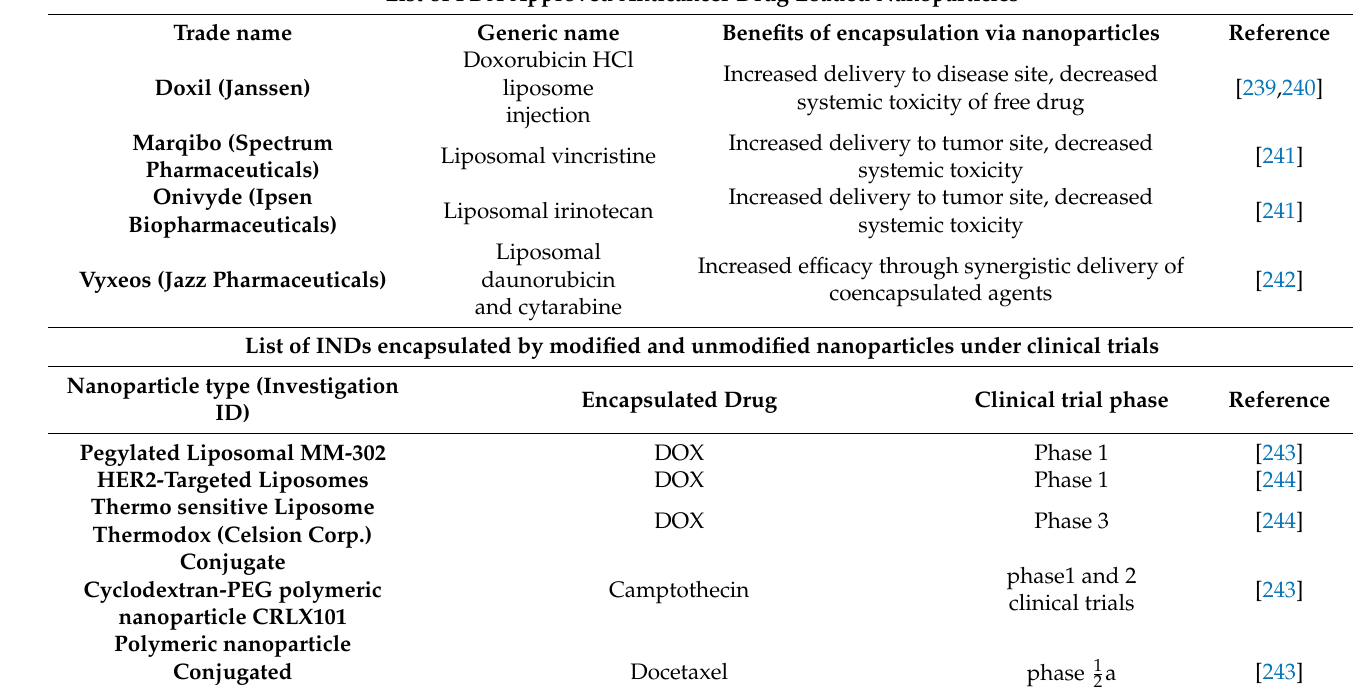
Table 4. List of FDA approved and under investigation nanoparticles encapsulated with anticancer drugs. List of FDA Approved Anticancer Drug Loaded